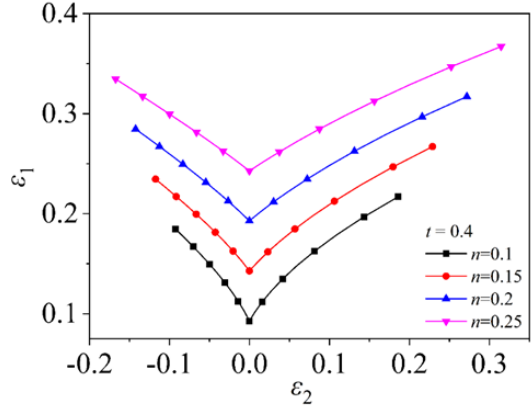
Figure 13. FLD for different values of n at t = 0.4.